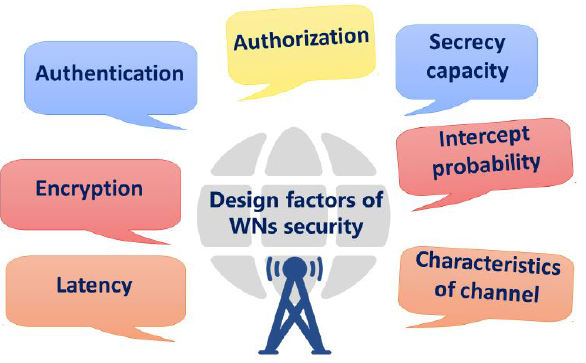
Figure 3. Design factors of wireless networks